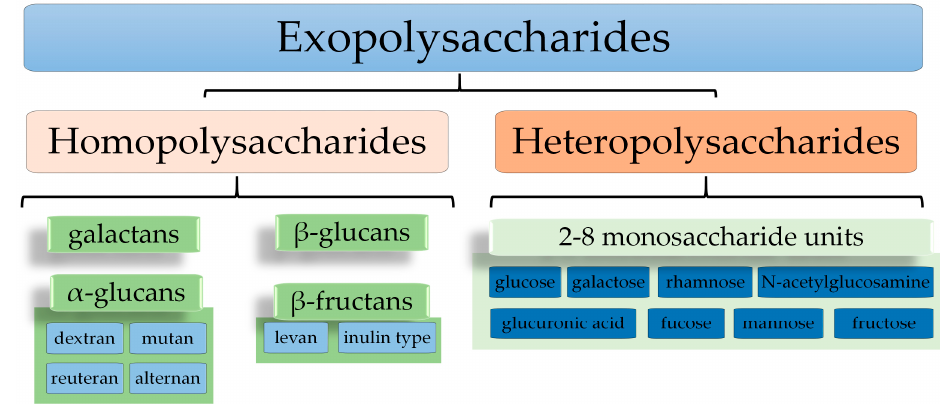
Figure 1. Classification of exopolysaccharides produced by lactic acid bacteria.